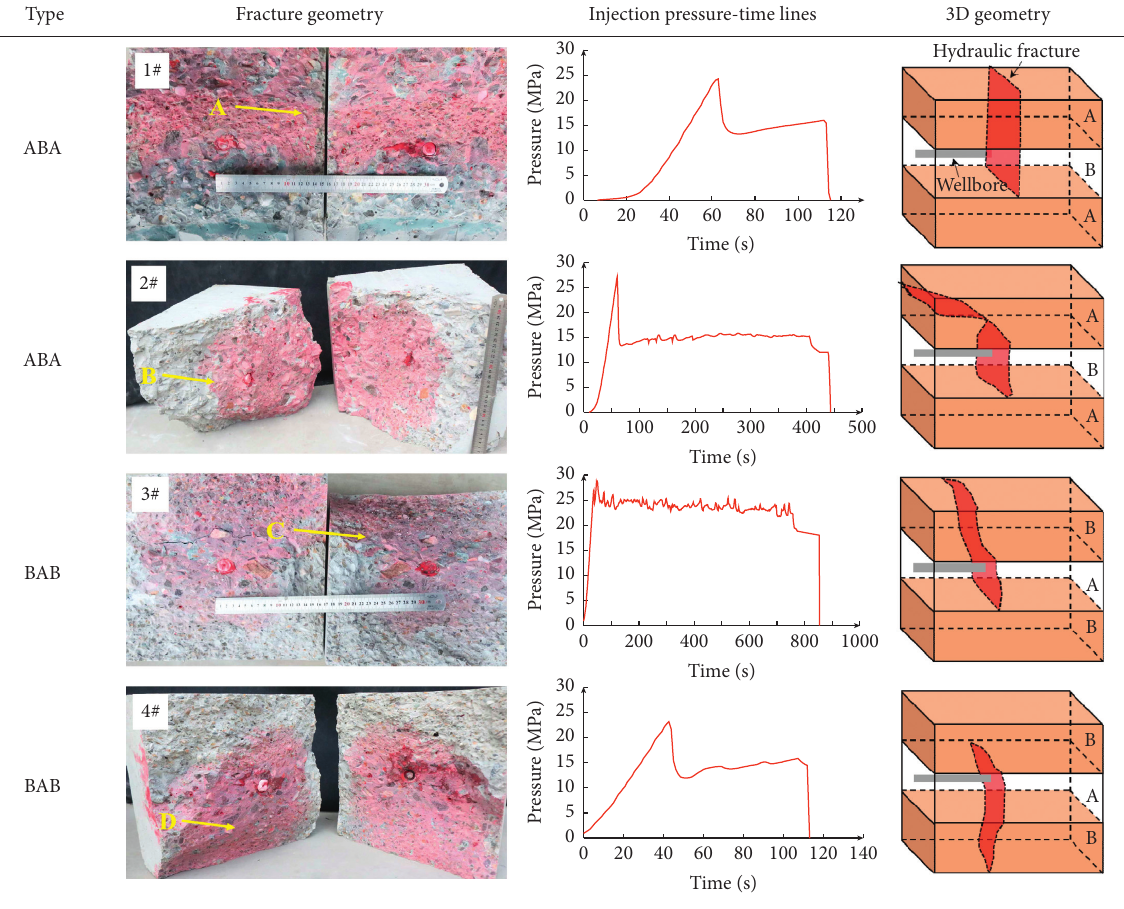
Figure 6: Hydraulic fractures and injection pressure-time lines of layered